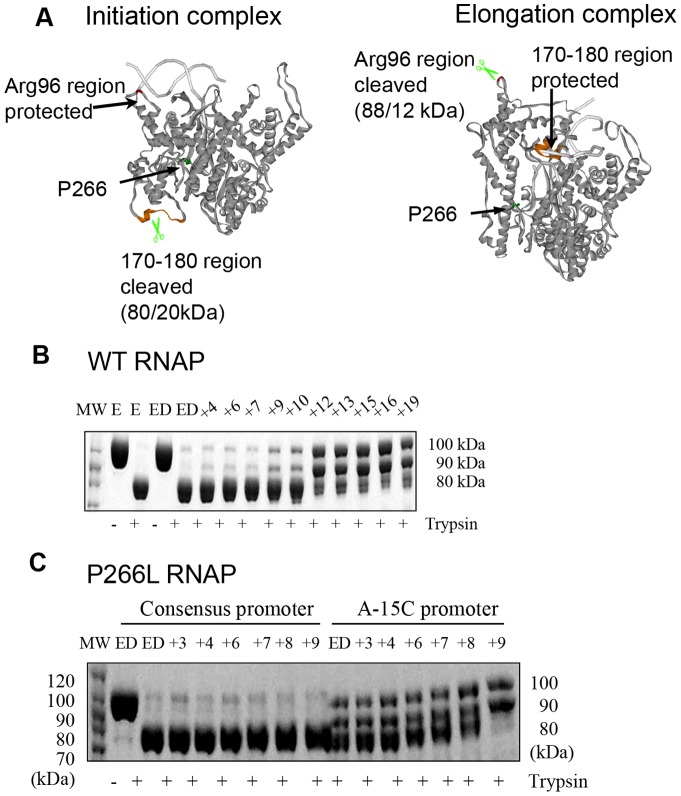
Subdomain H refolding is delayed in the P266L mutant.(A) T7 RNAP in initiation and elongation conformations have different exposure of Arg 96 (red color) and residues 170–180 (brown color) to trypsin digestion. Formation of an elongation complex is characterized by the disappearance of the 80 kDa fragment and the appearance of the 88 kDa fragment. P266 is colored in green. Limited trypsin digestion (15 s) of WT T7 RNAP after walking to +4 to +19 positions. E- RNAP, ED- RNAP:promoter complex (C) Same experiment as in panel B was carried out with P266L and consensus or A-15C promoter. The digestion pattern with the A-15C promoter shows that transition to EC occurs at +9 in the A-15C promoter, but not with the consensus promoter.